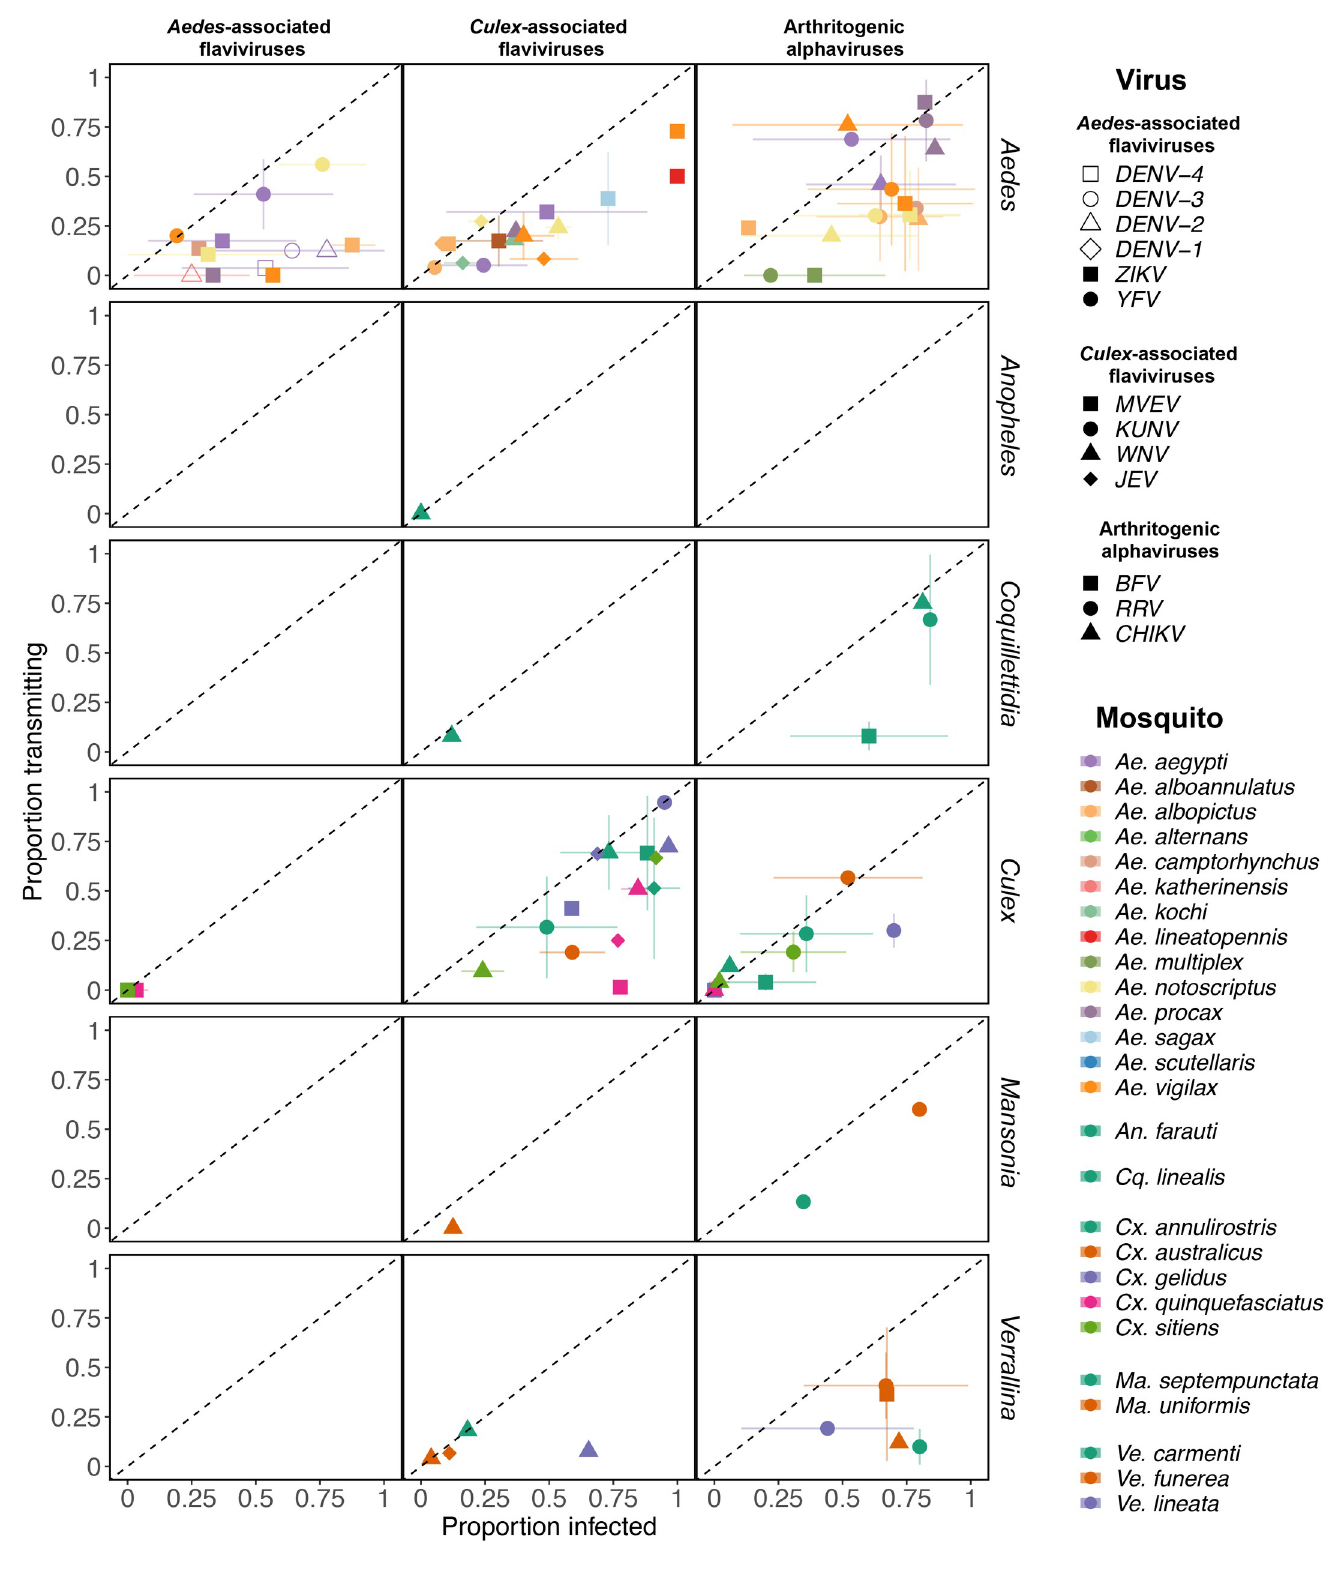
Fig 3. Raw proportion of mosquitoes (grouped by species: color and genus: rows) infected by (x-axis) and transmitting (y-axis) the viruses (shapes) separated by their viral grouping (columns). Each point shows the mean number of mosquitoes infected and transmitting across all experiments for that mosquito-virus pair; error bars show +/- one SD, calculated using the proportions across all experiments in that pair. Points without a horizontal or vertical error bar indicate pairs with only one